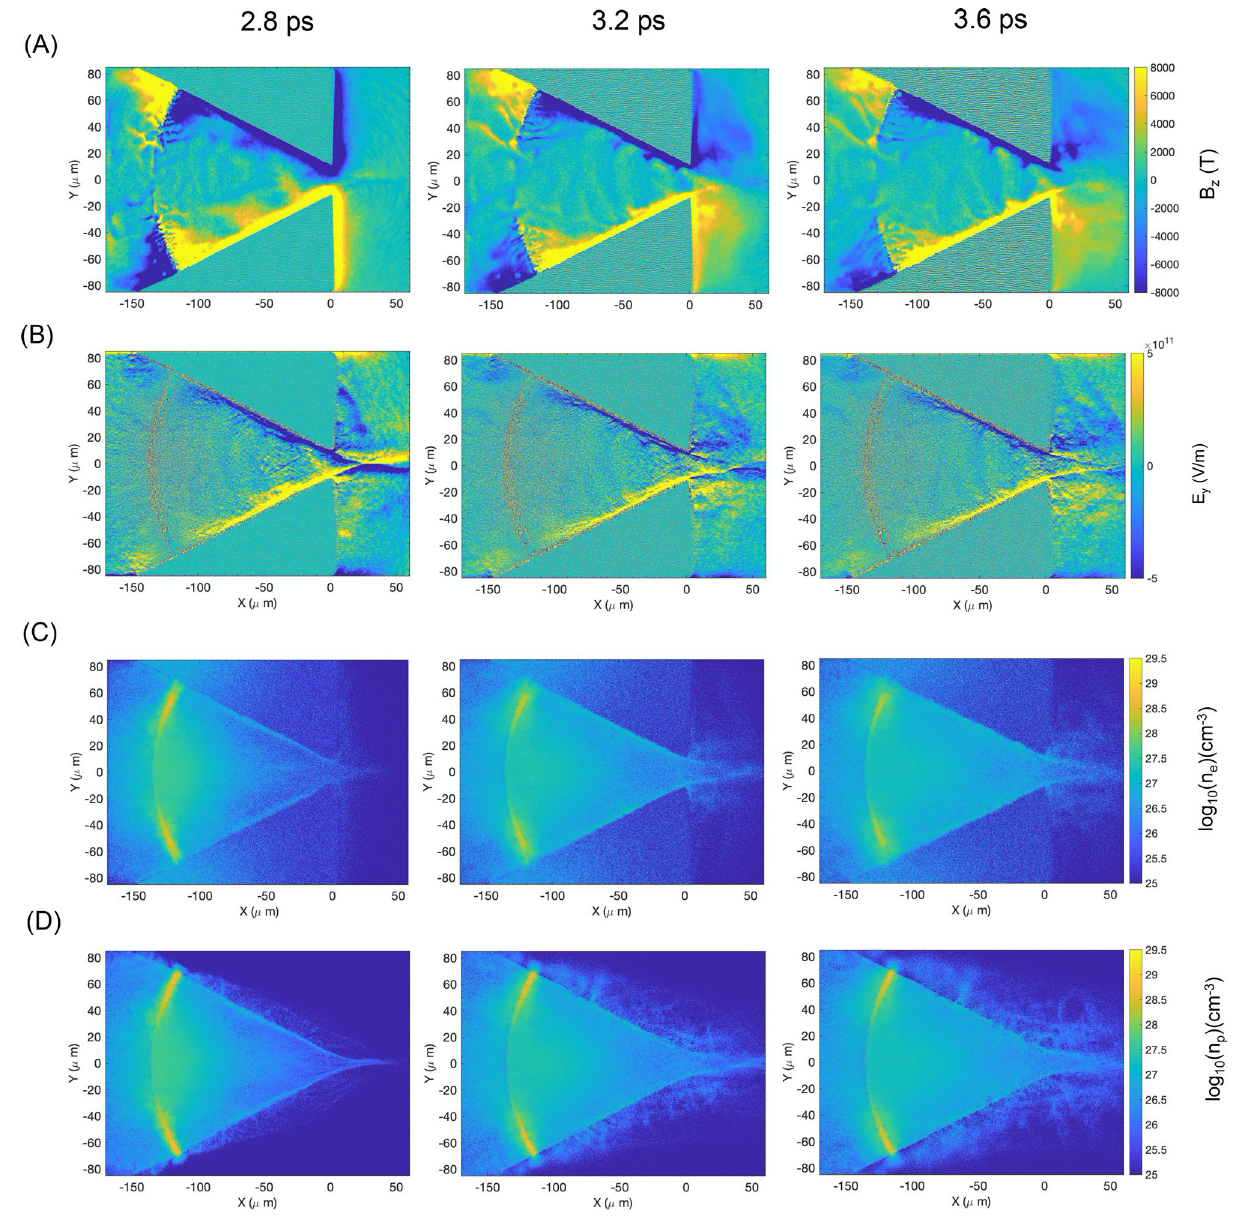
Figure 5. Bi-dimensional PIC simulations of proton beam generation and dynamics in tip-less buried cone targets. ( A ) Map of the Bz component of the magnetic field for simulation times of 2.8, 3.2 and 3.6 ps. At 2.8 ps we can observe the magnetic field compressed against the cone walls as in the free-standing cone case, with part of it flowing through the tip and along the outer rear surface of the target as the TNSA beam exits the cone. At 3.2 ps, as higher density TNSA plasma crosses the cone tip, part of the magnetic field is carried with the beam and forms a channel around it, which is maintained throughout the rest of the simulation. This B-field configuration prevents the hot electrons from radially expand and defocus the proton beam. ( B ) Map of the Ey component of the electric field for simulation times of 2.8, 3.2 and 3.6 ps. As the highest energy protons start exiting the tip at 2.8 ps, a strong de-focusing electric field surrounds the beam waist as result of the hot electron pressure. At later times of 3.2 and 3.6 ps we observe the disappearance of this de-focusing field, and the appearance of a focusing electric field structure in